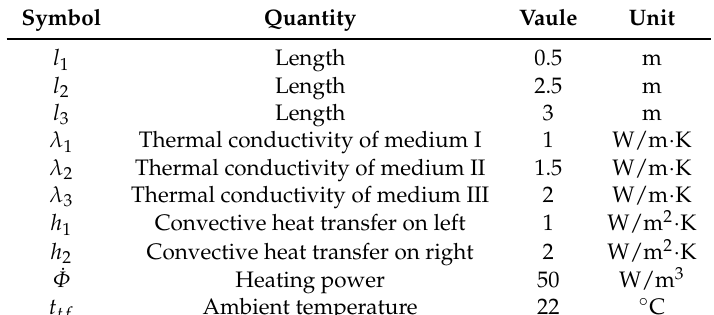
Table 1. Major parameters for the simulation.